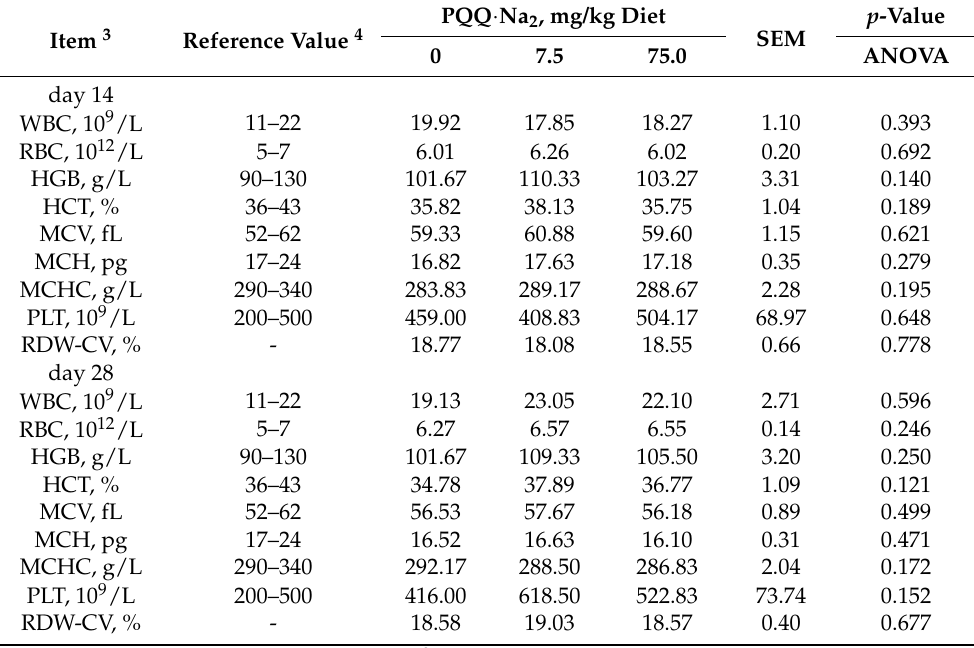
Table 4. Effects of graded levels of PQQ · Na 2 1 on hematological parameters of weaned piglets 2.